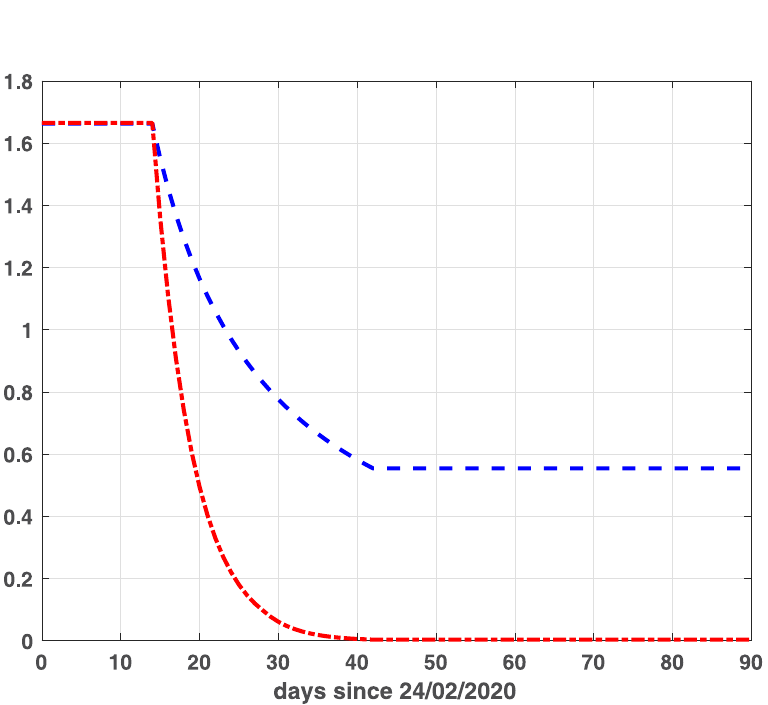
Fig 10. Infection rate in Lombardia. Infection rate functions β obtained by fSEIRDr and fSEIDRe respectively.